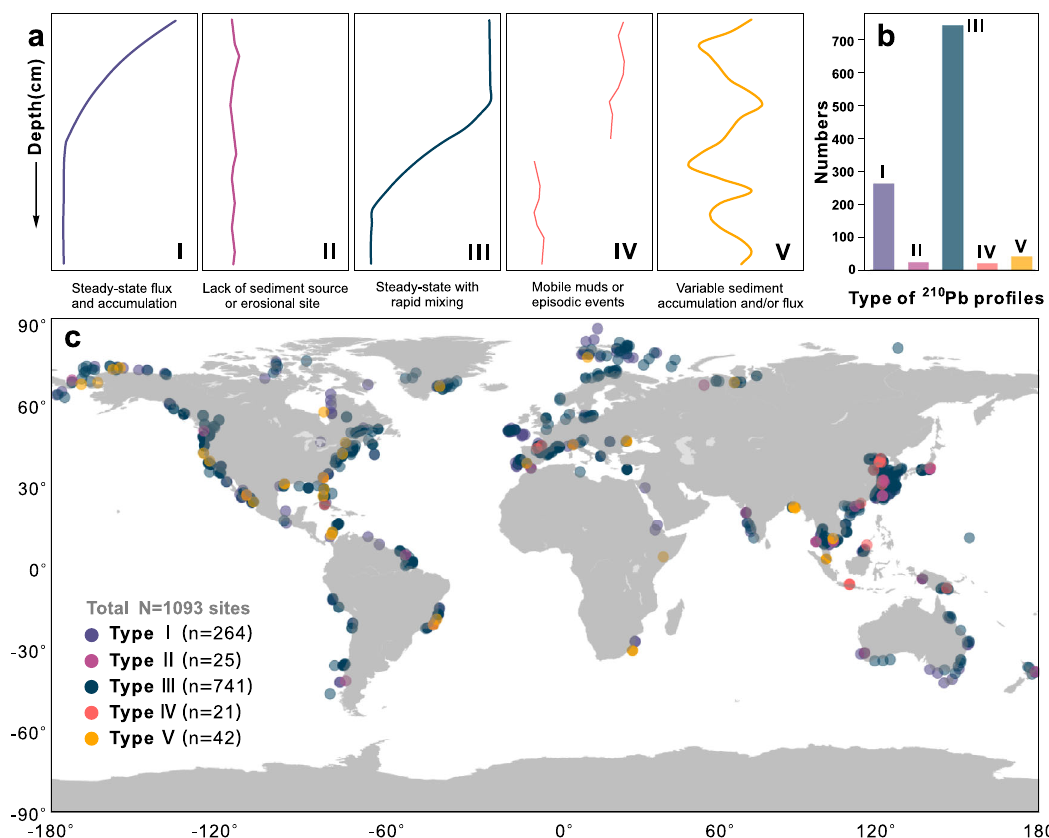
Fig.1|Pro fi lesofexcess 210 Pb( 210 Pb ex )inglobalcoastalocean. a Sketchesof fi ve sedimentary 210 Pb ex patterns in coastal areas based on downcore 210 Pb ex pro fi les; the x -axisrepresents 210 Pb ex activities.Thefrequency( b )andglobaldistribution( c ) of fi ve types of 210 Pb ex pro fi les in the global coastal ocean is based on data from